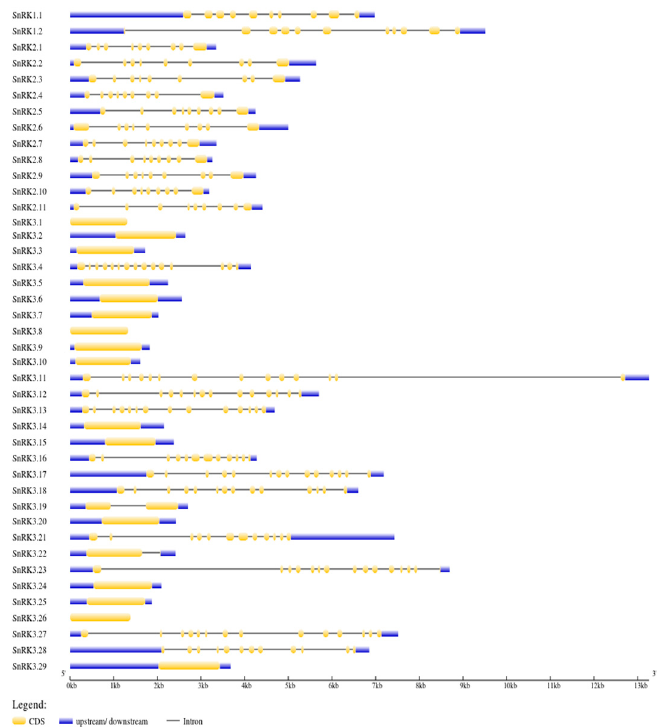
Figure 3. The exon–intron organization of the corresponding SnRK genes. The exons are represented by the yellow boxes, introns by black lines, and the untranslated regions (UTRs) are indicated by the blue boxes. The sizes of the exons and introns can be estimated using the scale detailed at the bottom.